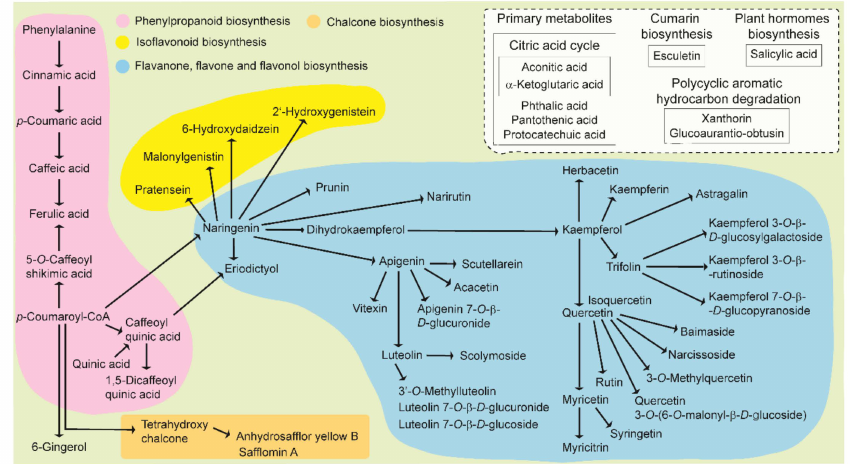
Figure 5. Simplified integrated metabolic pathways of phenylpropanoid, chalcone, isoflavonoid, flavanone, flavone, and flavonol biosynthesis in the florets of wild and cultivated sa ffl ower